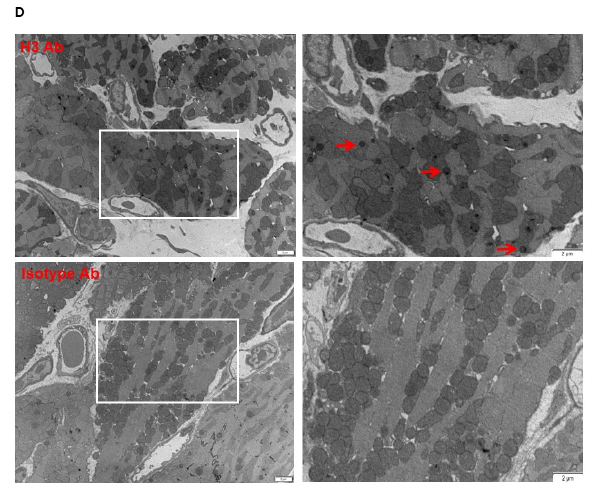
Figure 1. IYD inhibition by H3 Ab causes weight gain. ( A ) H3 Ab and isotype control antibody were injected (50 µg/mouse, i.p. , 2 times/week) into C57BL/6J mice for 3 weeks. Body weight was measured prior to treatment and then for 5 weeks. Significant differences between H3 Ab-treated and control mice on day 35 are indicated by ** p < 0.005 (Student’s t -test). Values are the mean ± s.d. for n = 7 mice. ( B , C ) H3 Ab and isotype control antibody were injected (50 µg/mouse, i.p. , 2 times/week) into C57BL/6J mice for 3 weeks. After euthanasia, mouse hearts were harvested and weighed and measured. Significant differences between H3 Ab-treated and control mice are indicated by * p < 0.05 (Student’s t -test). Values are the mean ± s.d. for n = 3 mice. ( D ) After H3 Ab (top) or isotype control antibody (bottom) were injected (50 µg/mouse, i.p. , 2 times/week) into C57BL6 mice for 3 weeks, the hearts were harvested and scanned by electron microscopy. The white squares on the pictures on the left indicate the areas that have been magnified on the corresponding images on the right. Red arrows indicate lipid droplets. Scale bars = 1 or 2 µm.